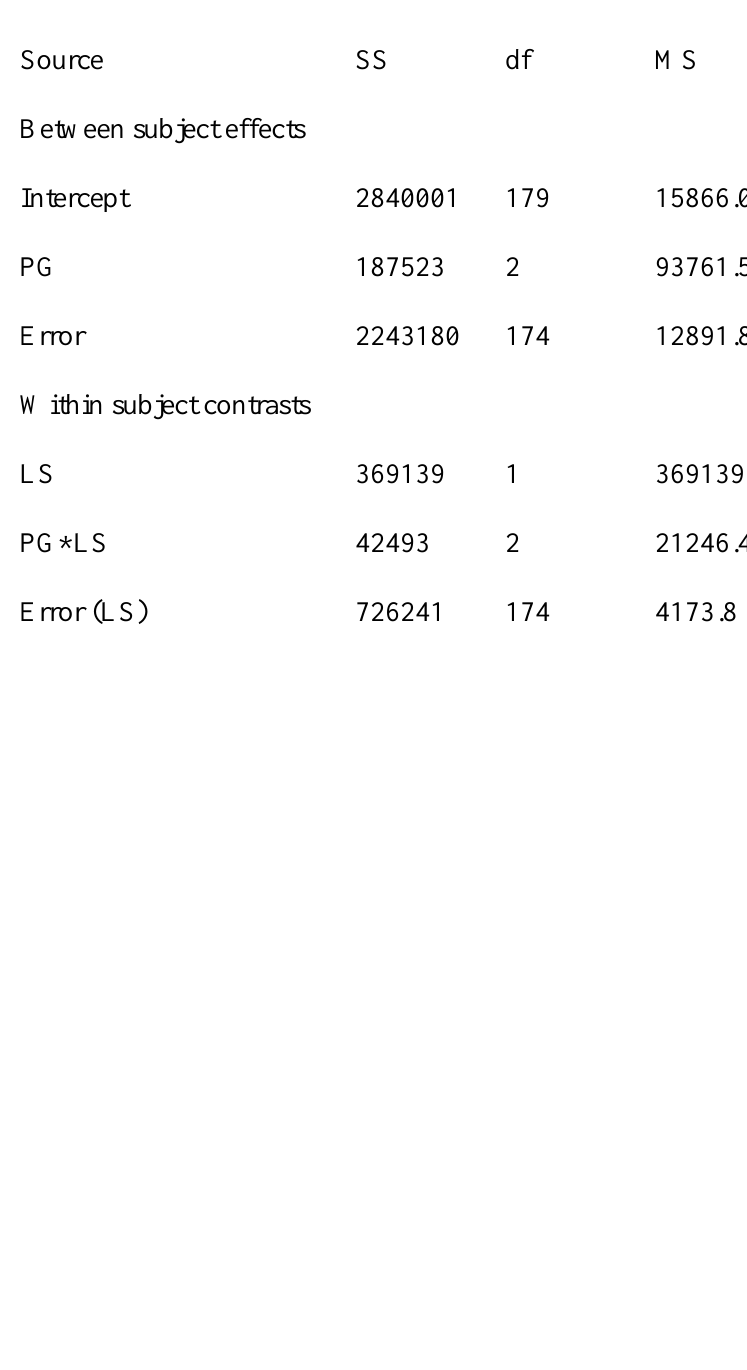
Table S5: Repeated measures-2-way-ANOVA of the normalized and ranked perception of intensity of odor from six decaying macrophytes. Phylogenetic groups (= PG, green plants, brown algae or red algae) were used as between subject factor and life strategy (= LS, opportunistic or non-opportunistic) was used as within subject factor. See also Figure